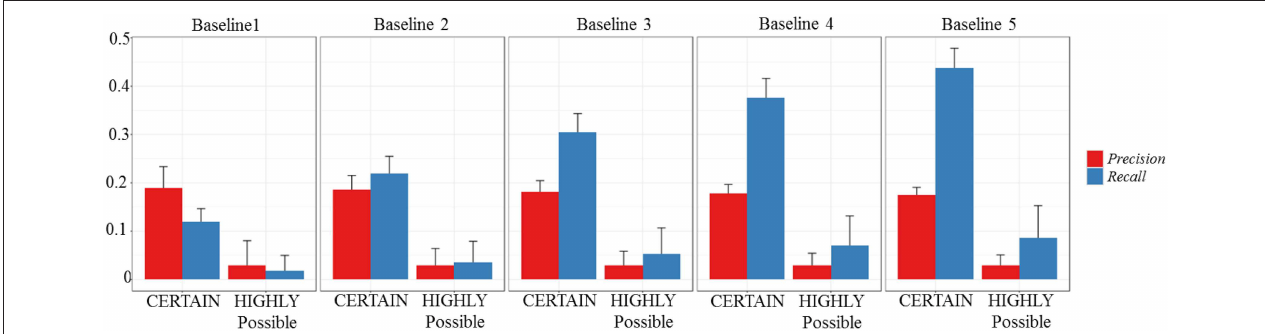
FIGURE 15 | Precision and Recall measures estimated for set of results predicted randomly. To each façade, from 1 (Baseline 1) to 5 (baselines 5) failure modes are associated. CERTAIN and HIGLY Possible failure modes are randomly generated with the same probability of occurrence of the failure modes observed on site.